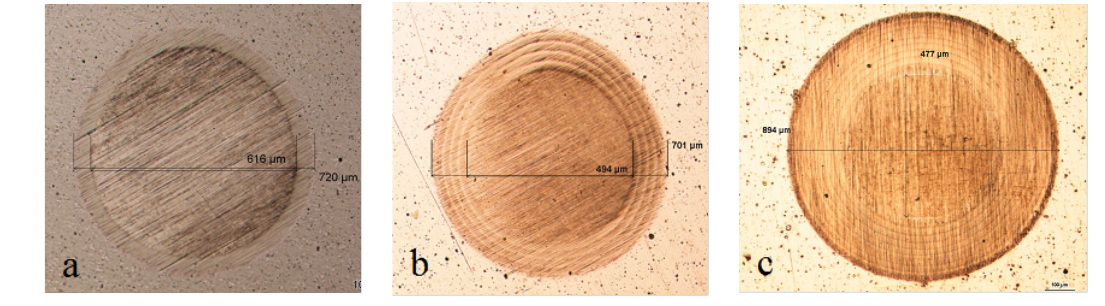
Figure 3. Ball crater print on X153CrMoV12 coated steel: ( a ) Monolayer; ( b ) Multilayer 4; ( c ) Multilayer 8.